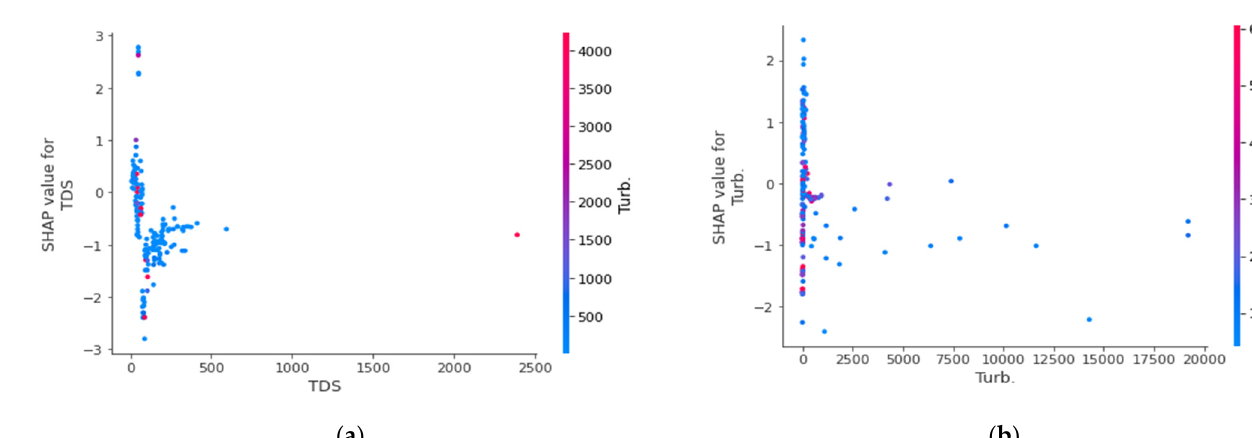
Figure 9. SHAP dependency and interaction effect plots for low As concentrations: ( a ) TDS; ( b )Turb; ( c ) Cond; and ( d ) pH.